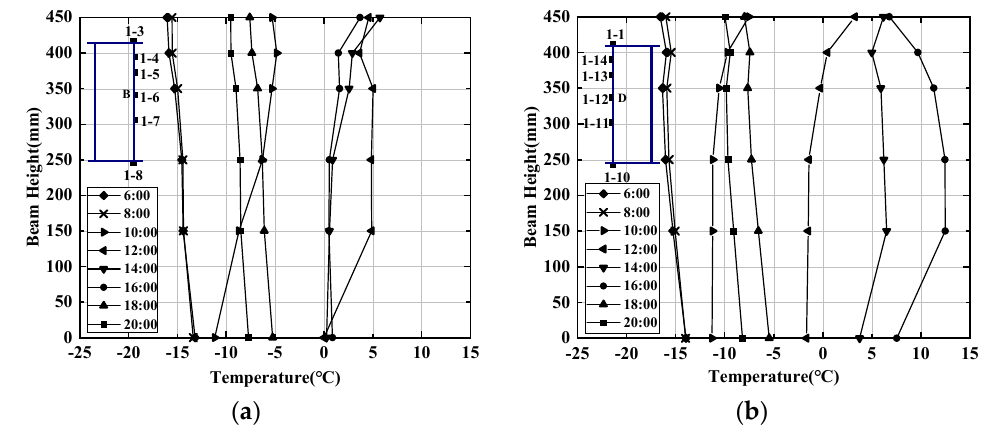
Figure 6. Vertical temperature gradient of the steel box girder at various times (30 July 2021). ( a ) Plate B; ( b ) plate D.